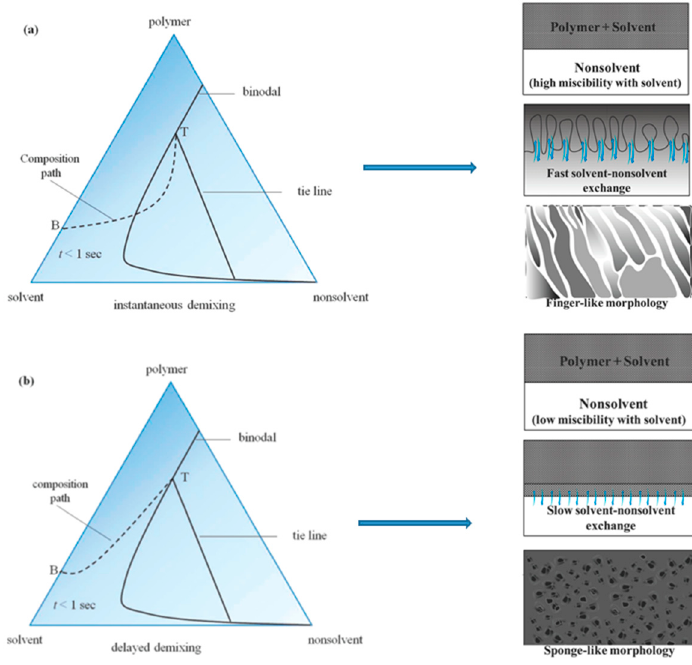
Figure 3. Different membrane morphologies associated to different types of demixing, adapted from reference [71]. [A color figure can be viewed in the online issue, which is available at wileyonlinelibrary.com.].